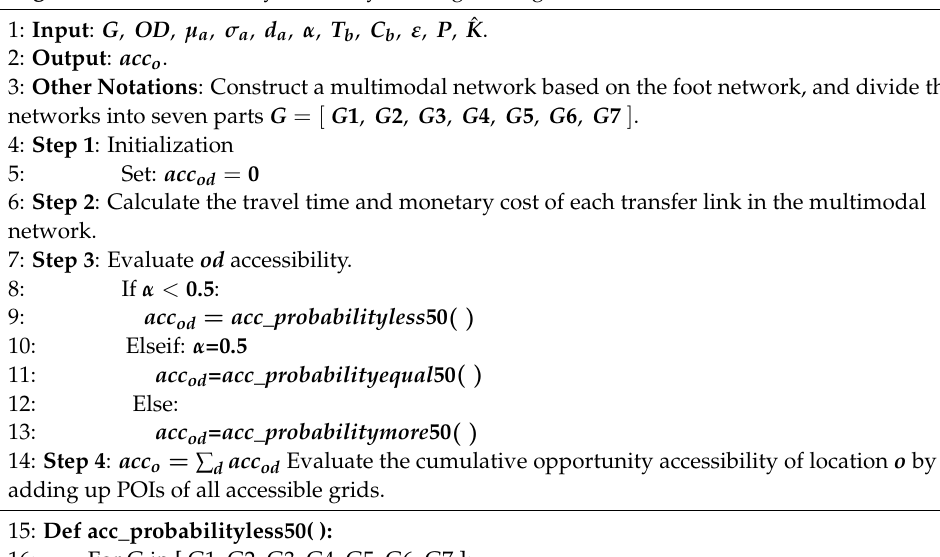
Algorithm 1 The reliability boundary convergence